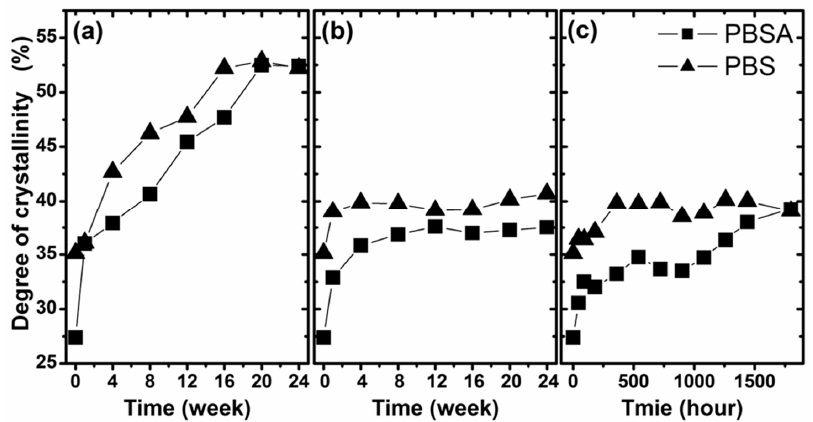
Figure 6. Changes in the crystallinity of the studied samples during degradation in selected environments: ( a ) biodegradation in compost, ( b ) biodegradation in soil and ( c ) artificial weathering.